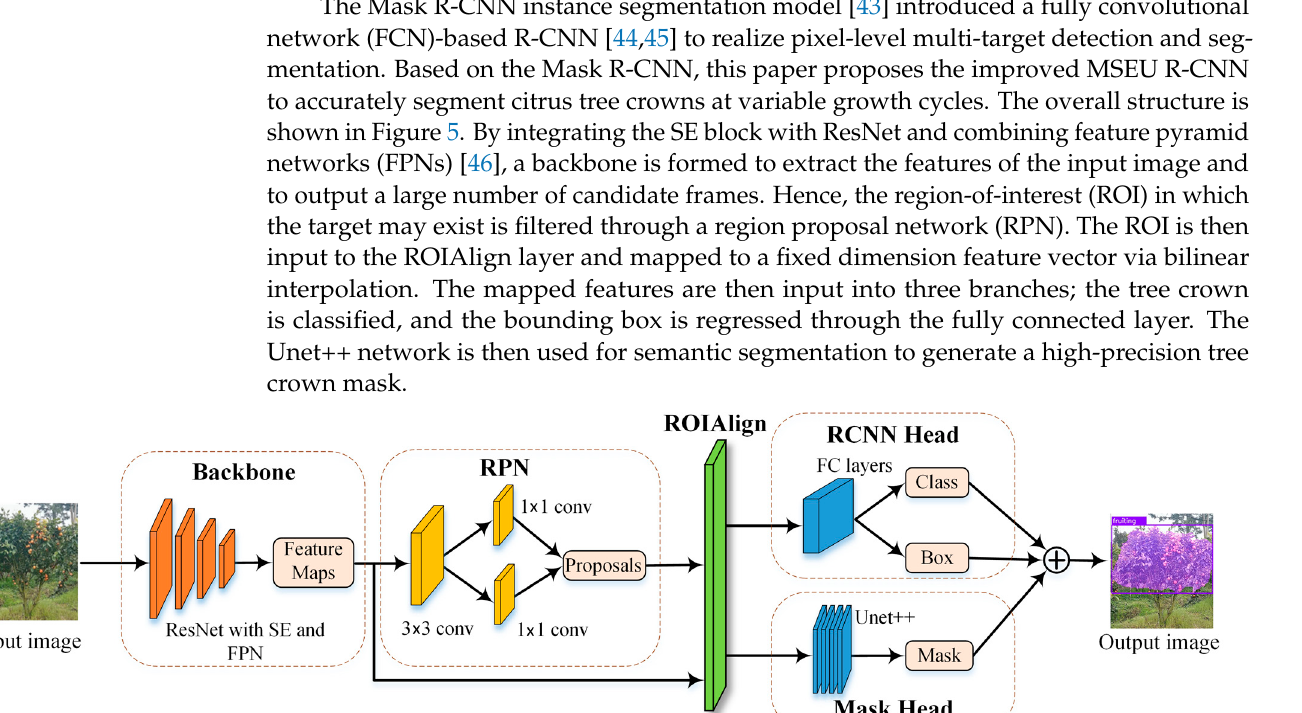
8 of 21 Table 2. Image distribution of citrus crown after data augmentation. Dataset 1 Dataset 2 Growth